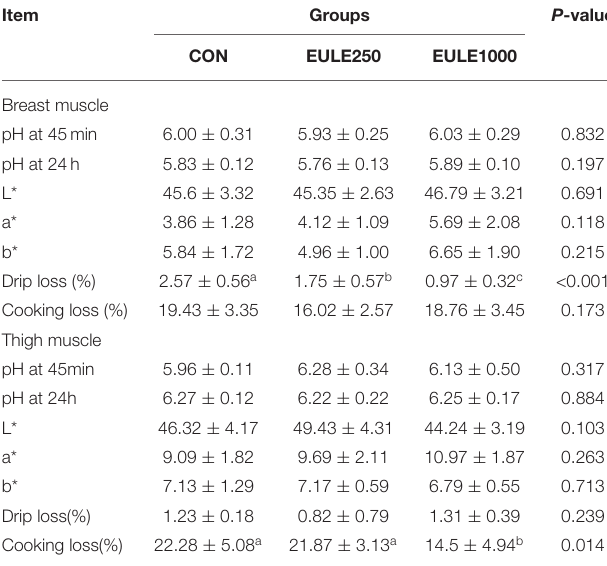
Data represent the mean value of six samples per treatment. L * , lightness; a * , redness; b * , yellowness. Data were shown as means ± SD. In the same row, values with different small letter superscripts mean a significant difference (P < 0.05).